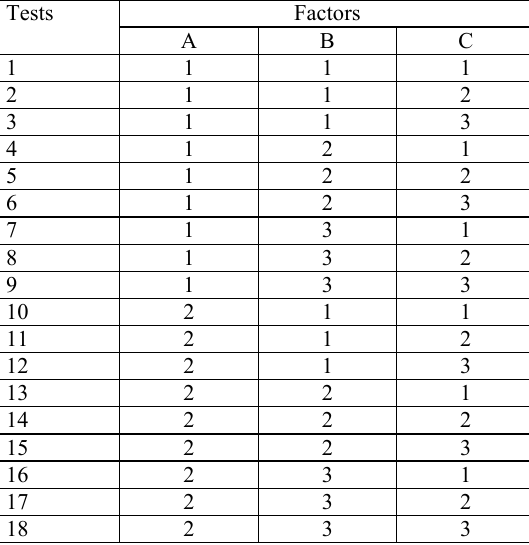
Table 3. Taguchi L18 array test design